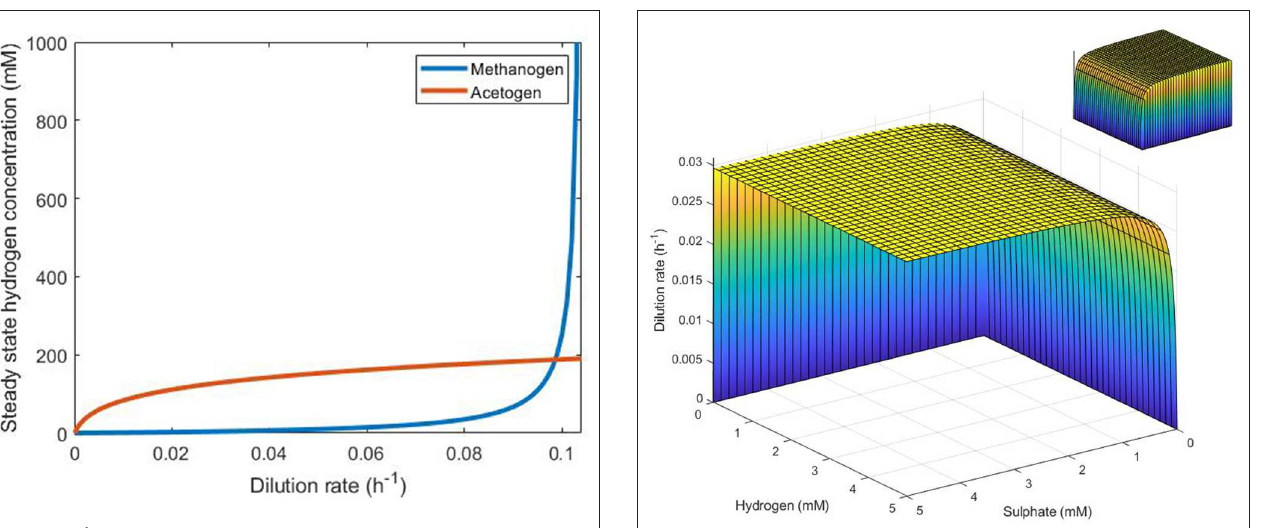
FIGURE 6 | Surface representation of conditions necessary for SRB survival in the absence of lactate. SRB survival requires that conditions represent a point below the surface. Note the inverted sulfate and hydrogen axes. Inset: reverse